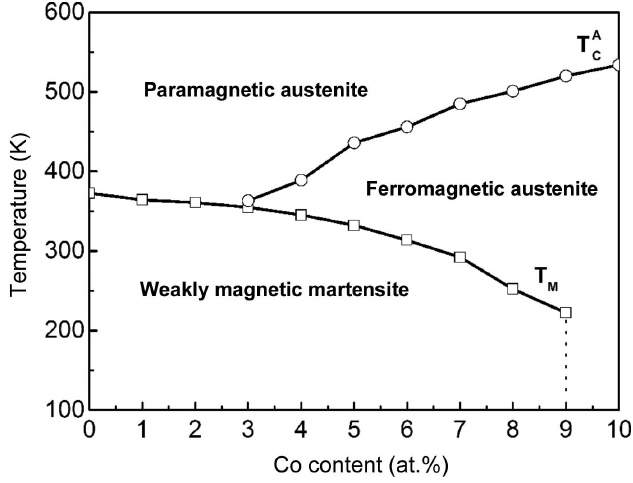
Figure 7 Phase diagram showing the compositional dependence of the martensitic transformation and magnetic transition in Mn 50 Ni 42 (cid:2) x Co x Sn 8 melt-spun ribbons with 0 (cid:3) x (cid:3) 10.